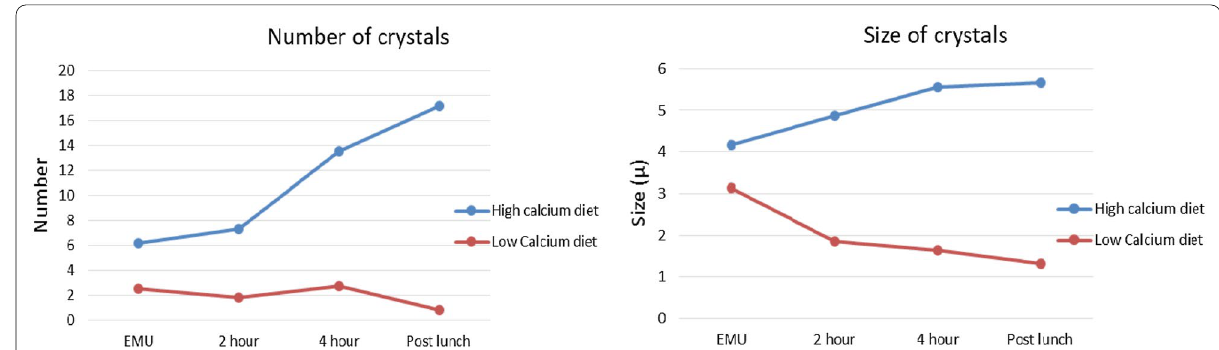
Early morning urine sample, =